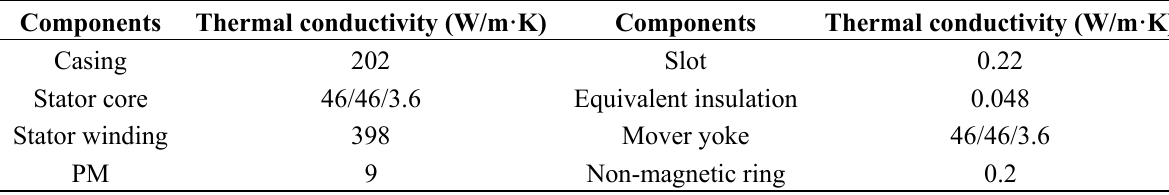
Table 5. Thermal conductivities of different